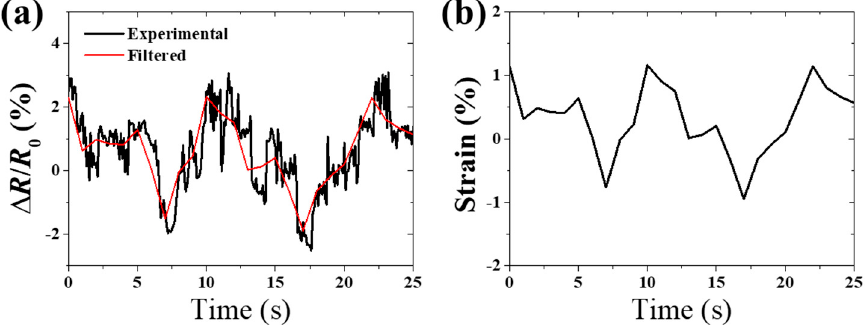
Figure 9. ( a ) The resistance change ratio of the EES under the movement of human hand. ( b ) The human skin strain of a certain part of the wrist measured by the EESs.